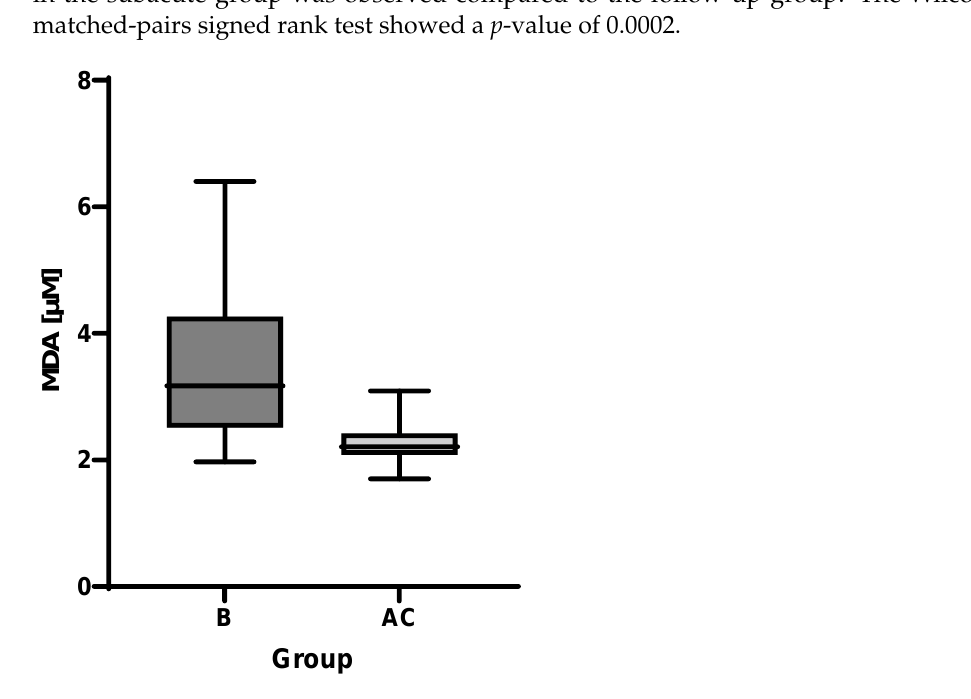
Figure 3. Boxplot of malondialdehyde (MDA) plasma levels in subacute (B) and follow-up (AC) groups.